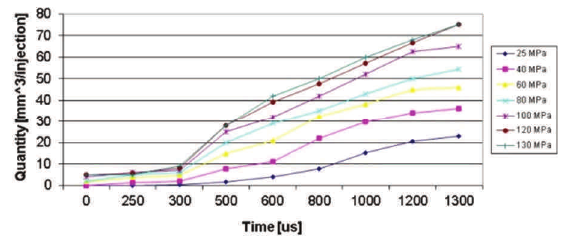
Fig. 11. Characteristic of improper injector work 0 445 110 200